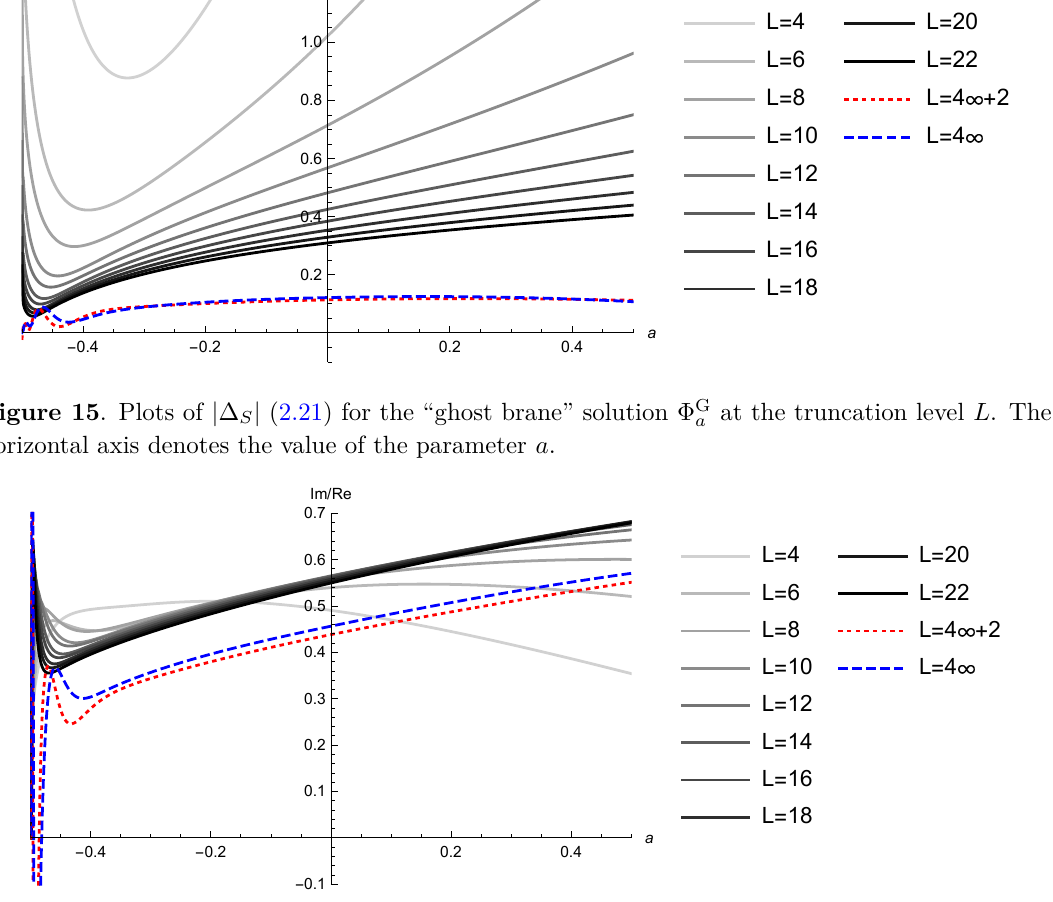
at the truncation level L . The a